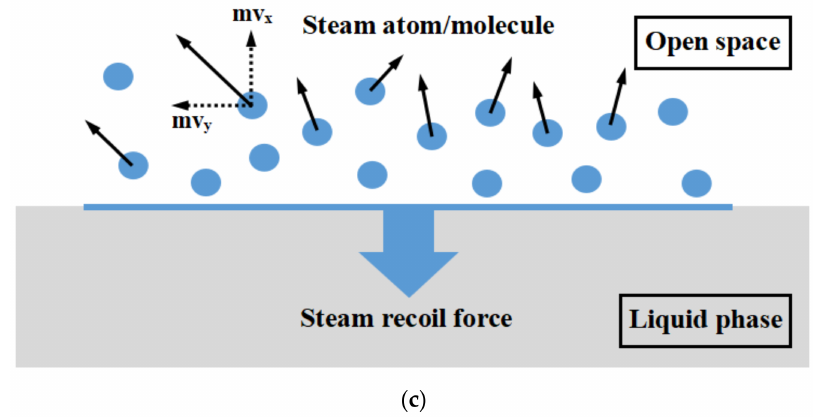
Figure 5. ( a ) Surface tension. ( b ) Marangoni effect. ( c ) Steam recoil